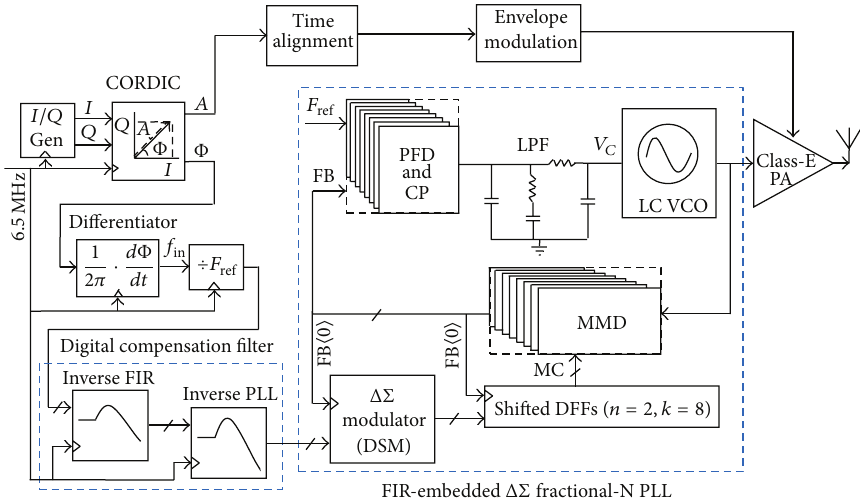
Figure 3: Proposed low-noise ΔΣ phase modulator with compensated-FIR filtering for polar